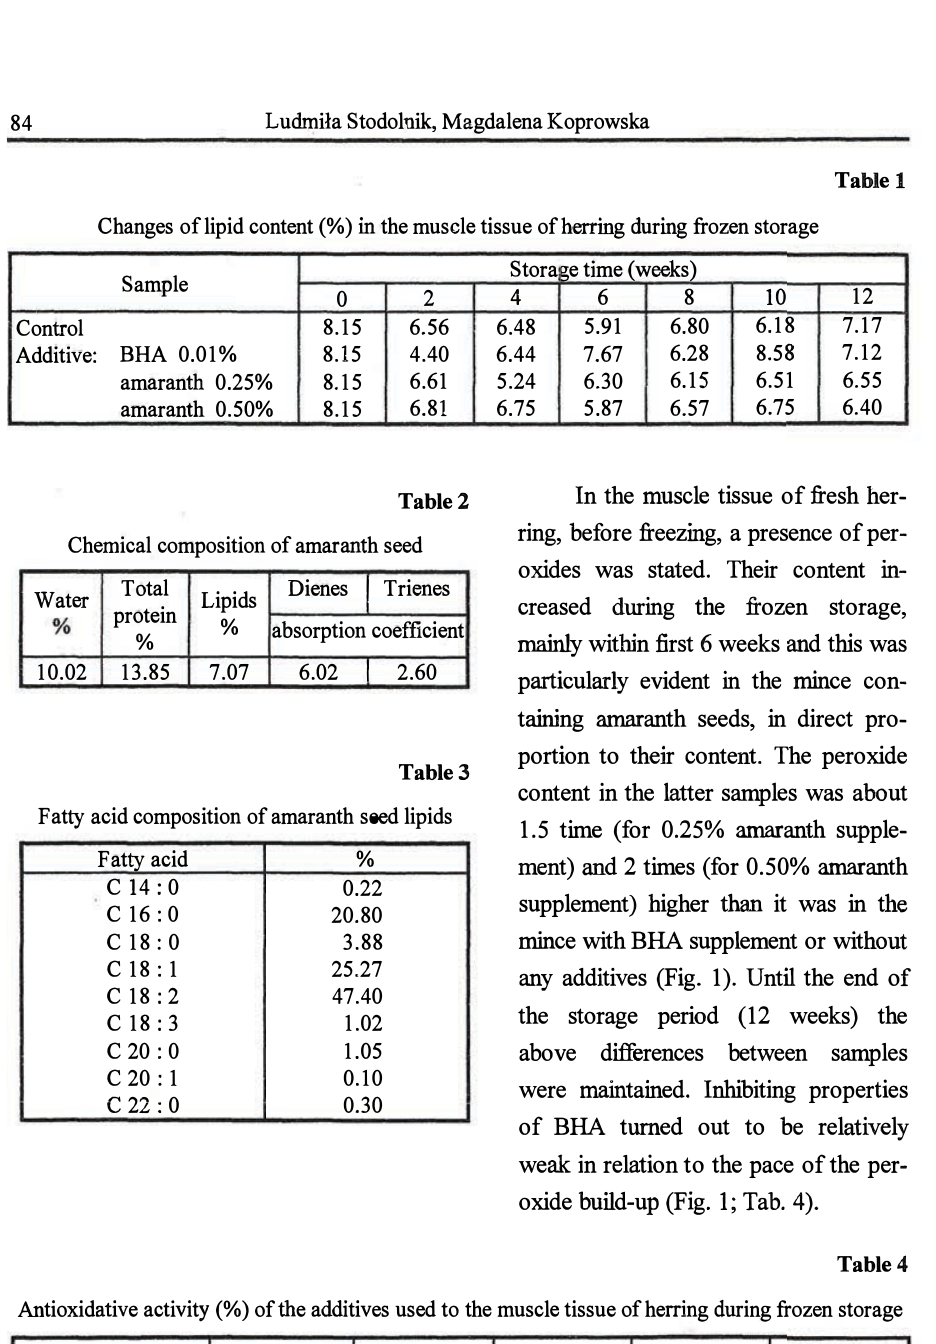
Changes of lipid content(%) in the muscle tissue of herring during frozen storage Sample